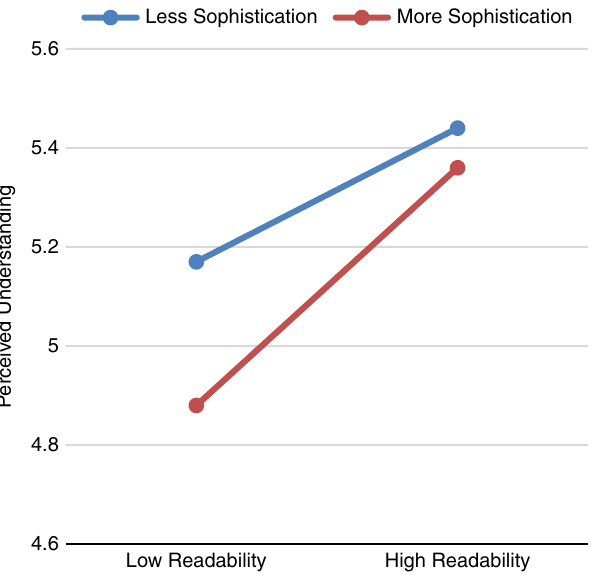
Figure 2. Perceptions of understanding by readability